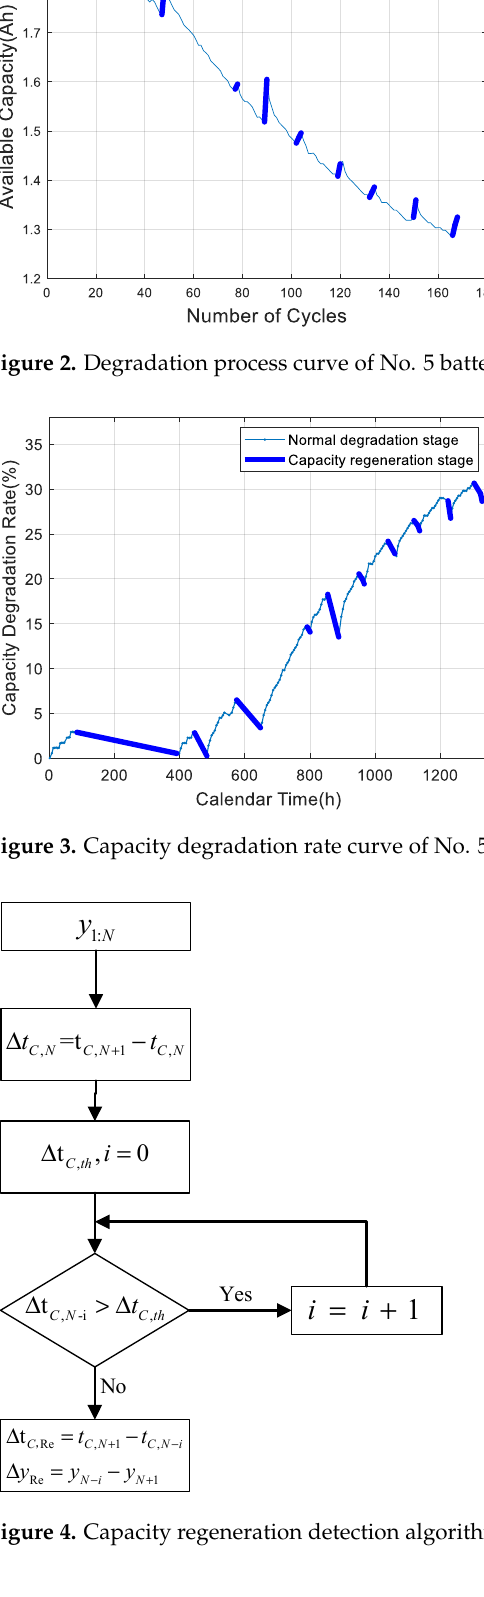
Figure 4. Capacity regeneration detection algorithm flow chart.